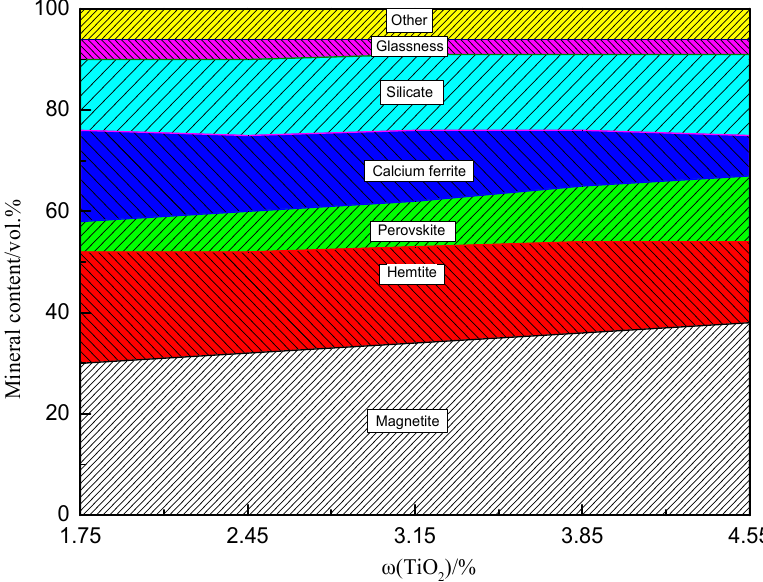
Figure 6. Mineral composition of the LVTM sinter with different TiO 2